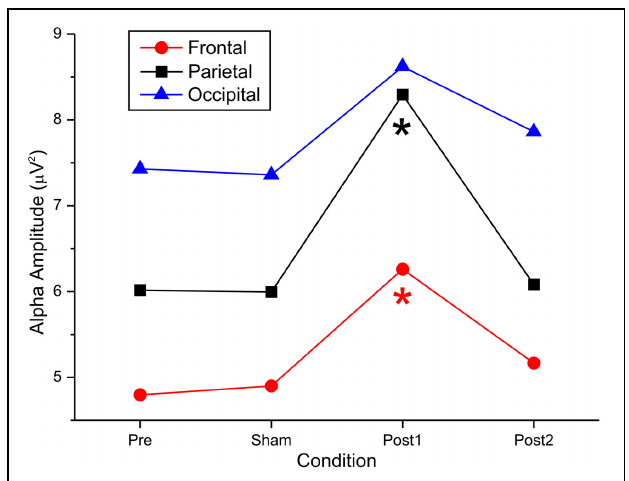
FIGURE 4 | Topographical maps (top flat view) of the alpha rhythm at 10.5Hz in 4 conditions—pretest, sham, posttest1, and posttest2—with the eyes were open (upper panel) and closed (lower